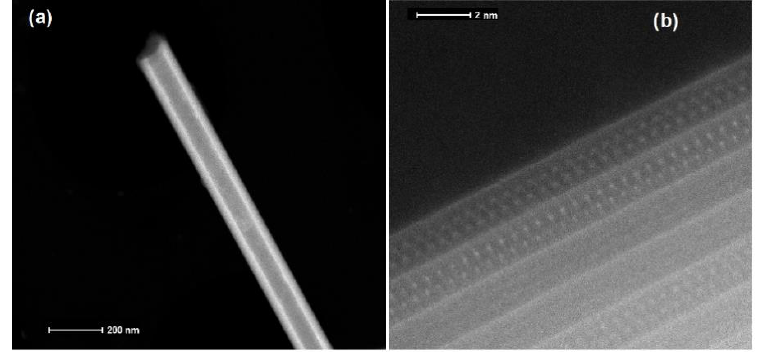
Figure 4. High angle annular dark field-scanning TEM (STEM-HAADF) low resolution images of Sr 0.1 La 0.9 S-TaS 2 (Sr 10 atom %) nanotubes. ( a ) An overall image of the nanotube and ( b ) high-resolution image of (a) showing that TaS 2 is the outermost layer of the nanotube. The image also shows that some of the Sr x La 1 − x S double layers are oriented with their [110] axis parallel to the beam, while others are out of focus, indicating that they are tilted with respect to the beam (adapted from [27] courtesy of Dr. L.F. Deepak).